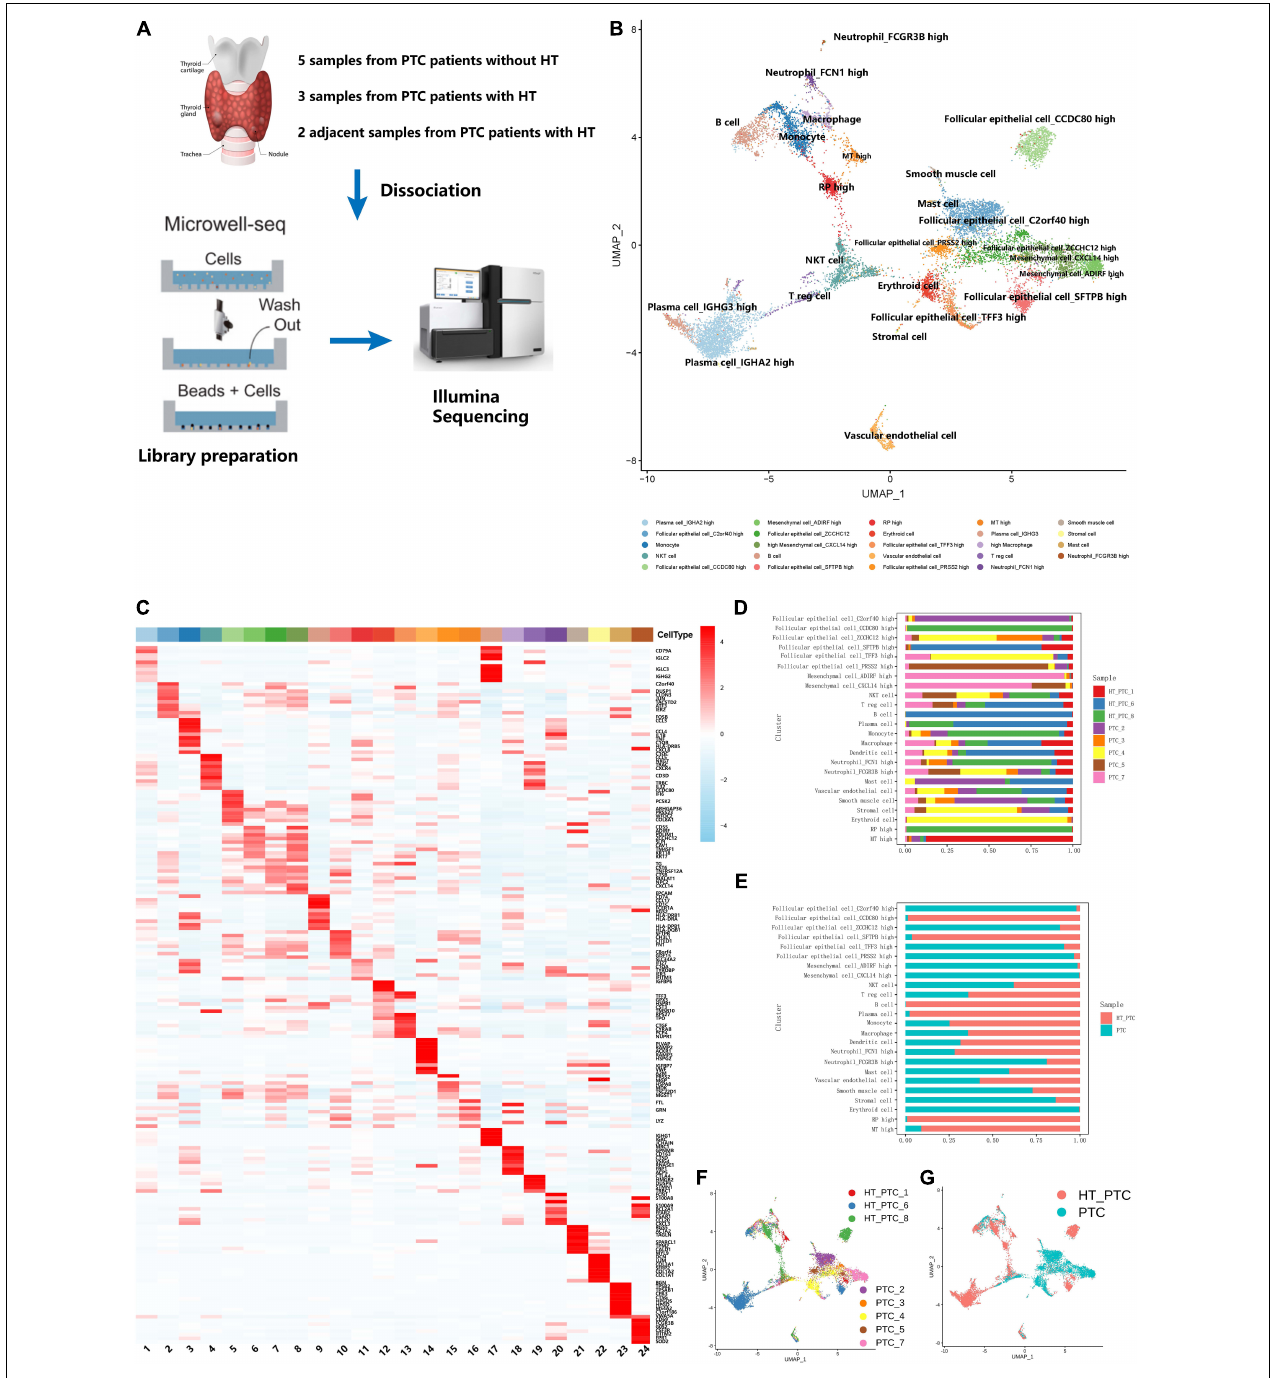
FIGURE 1 | Single-cell transcriptome landscape of papillary thyroid cancer. (A) Workflow of sample dissociation, library preparation, and sequencing. (B) UMAP plot of subclusters in PTC cell landscape. (C) Heatmap of specific marker genes of paired clusters in (B) . (D) The fractions of samples in each cell subcluster. (E) The fractions of sample types in each cell subcluster. (F) UMAP plot of cells colored by PTC patients. PTC, samples from PTC patients without concurrent HT; HT_PTC, samples from PTC patients with concurrent HT. (G) UMAP plot of single cells colored by PTC types.